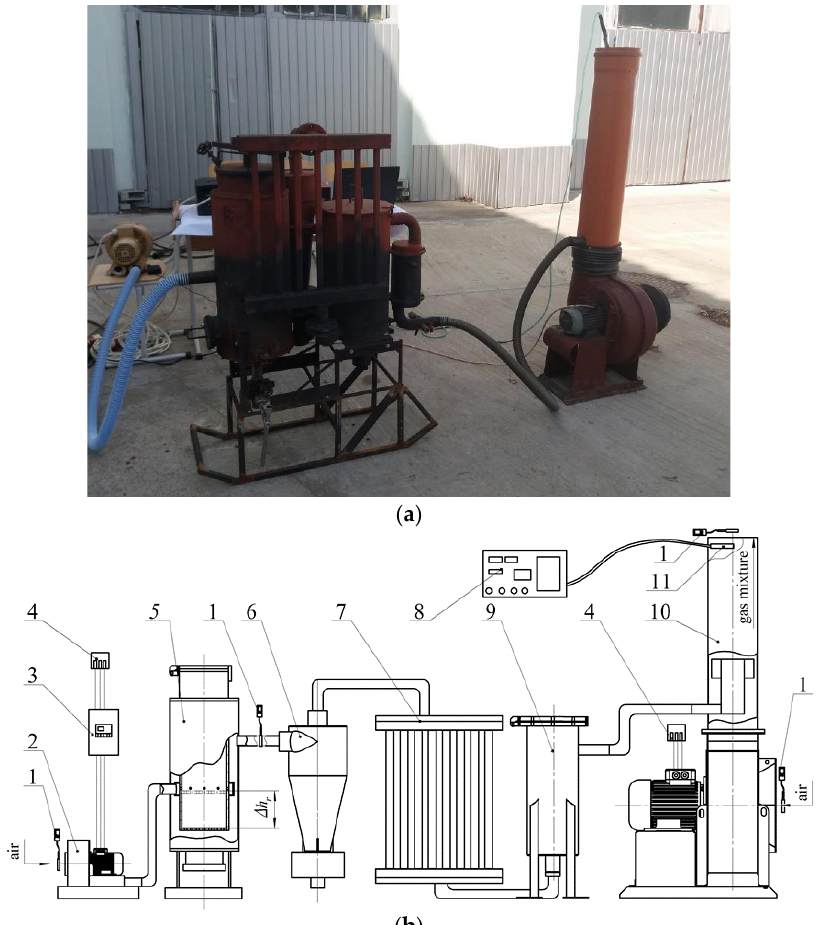
Figure 1. General view ( a ) and a scheme ( b ) of plant number 1 for conducting research: 1—an anemometer, 2—an air blower (an oxidant blower), 3—a frequency converter, 4—an electric power source, 5—a downdraft gasifier, 6—an intermediate purification filter, 7—a cooler, 8—a chemical analyzer of gas content, 9—a filter for final gas purification, 10—a mixer, and 11—an analyzer sensor 8.